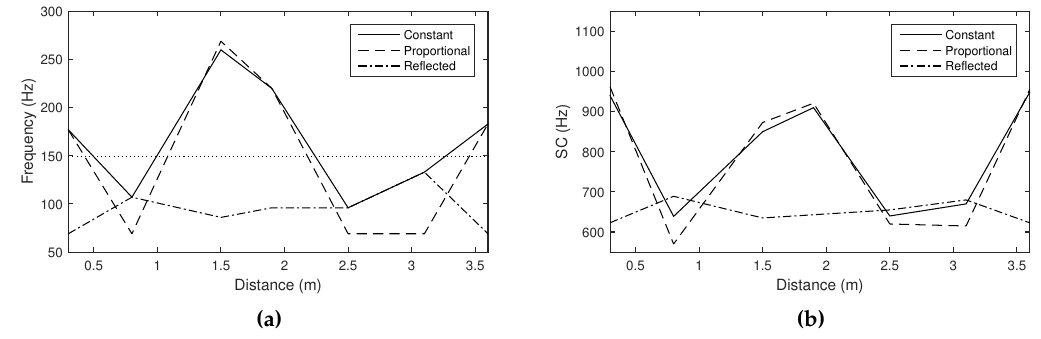
Figure 16. Approximated ( a ) resonant frequencies and ( b ) spectral centroids according to the distance between the loudspeaker and the microphone, with different cutoff frequency settings of the low-pass filter: constant (straight lines), determined by the measured resonant frequency, using the proportional ( L 1 , dash lines) and reflected mappings ( L 2 , dash-dot lines). The threshold was set to 140 Hz (dot line in ( a )).